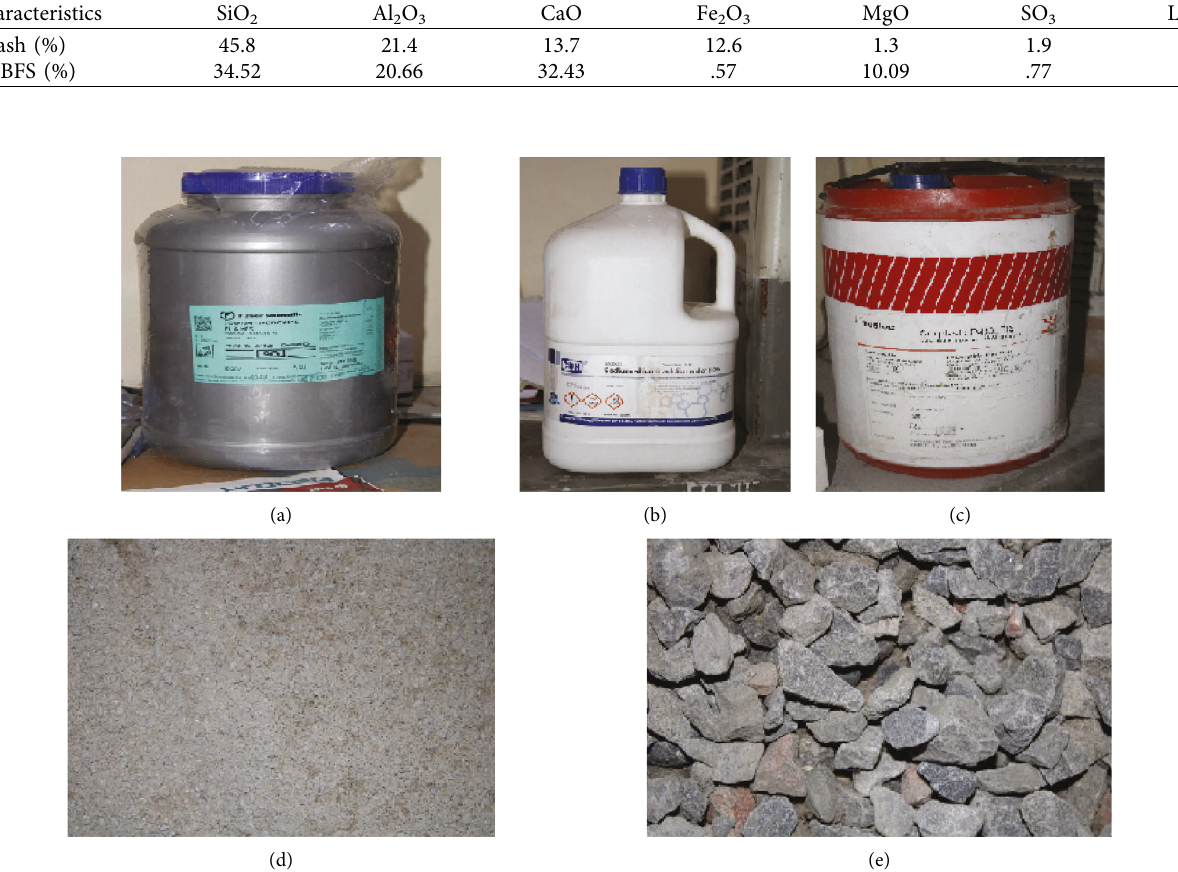
Figure 2: Picture of raw materials of the GPC (a) sodium hydroxide flakes, (b) sodium silicate solutions, (c) superplasticizer, (d) stone-dusts, and (e) coarse aggregates.